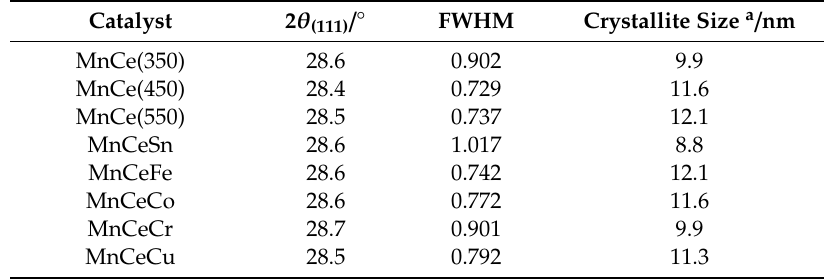
Figure 1. XRD patterns of MnO x -CeO 2 based catalysts, ( a ) MnO x -CeO 2 with different calcination temperature, ( b ) MnO x -CeO 2 with metal doping. temperature, ( b ) MnO x -CeO 2 with metal doping. Table 1. Crystallization properties of MnO x -CeO 2 based